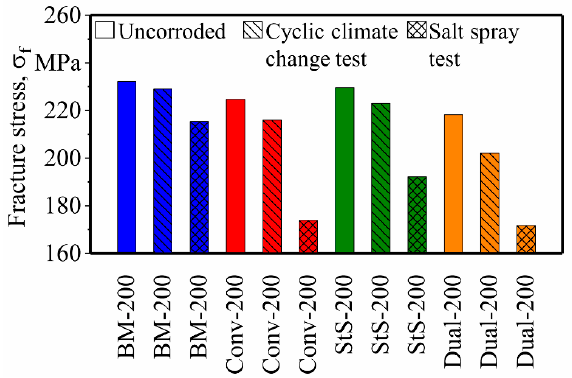
Figure 21. Summary of the effect of the corrosion tests on the fracture stresses of base and friction stir welded (FSW) EN AW-5754 specimens.